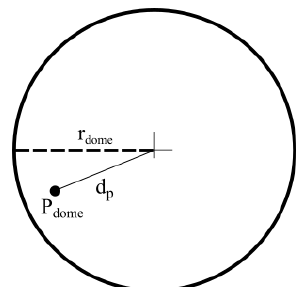
Figure 24. Sun position in the dome.